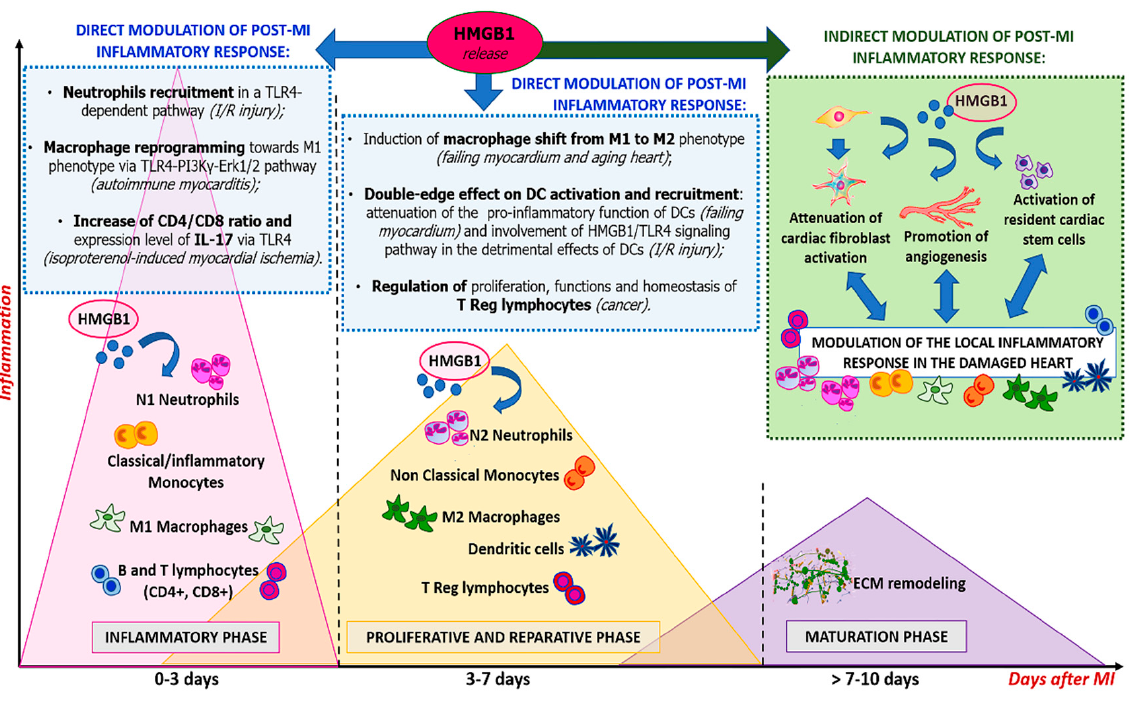
Figure 2. Role of extracellular HMGB1 in modulation of post-MI inflammatory response. HMGB1